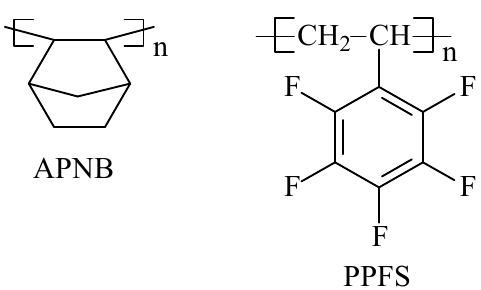
Figure 7. The structures of addition polynorbornenes (APNB) and poly(pentafluorostyrene)